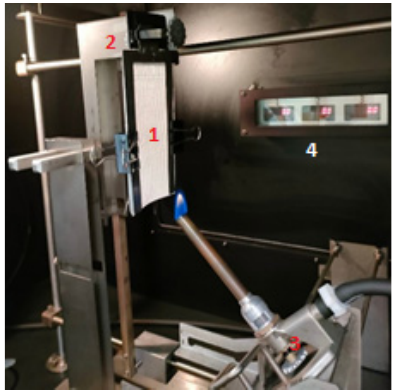
Figure 3. Test chamber of the used equipment for ignitability tests.